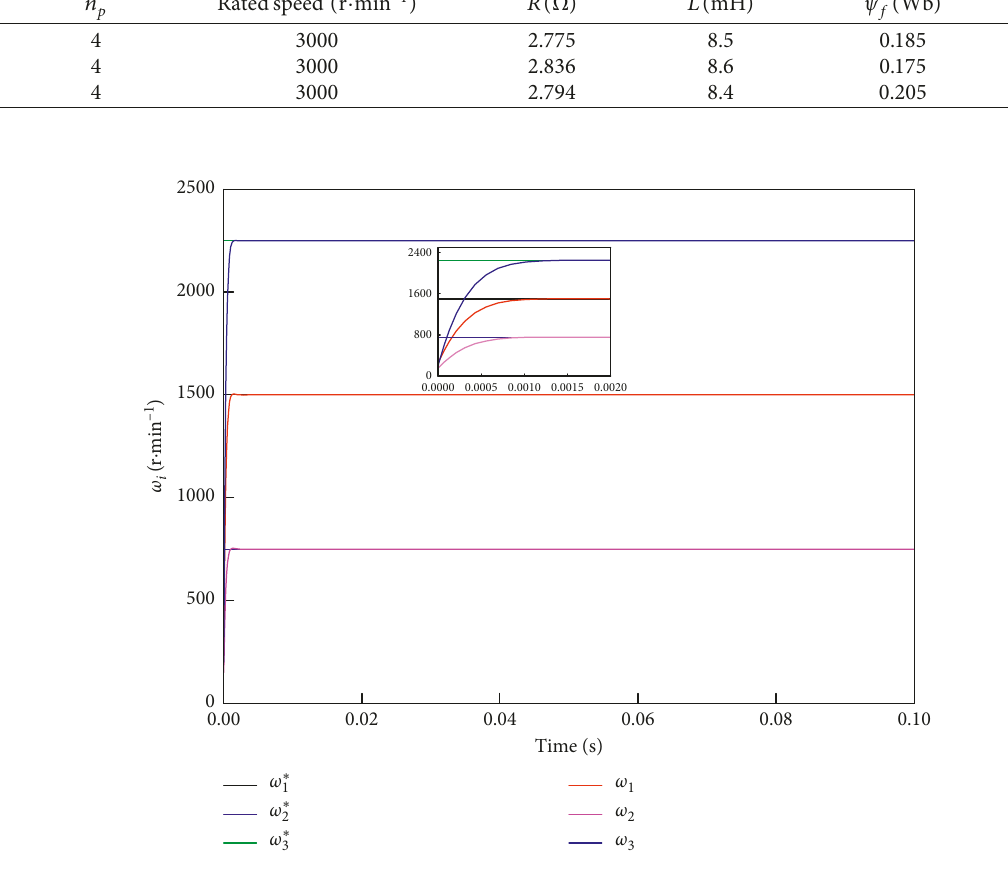
Figure 3: The velocity tracking curves of all servos under the sliding mode variable control.